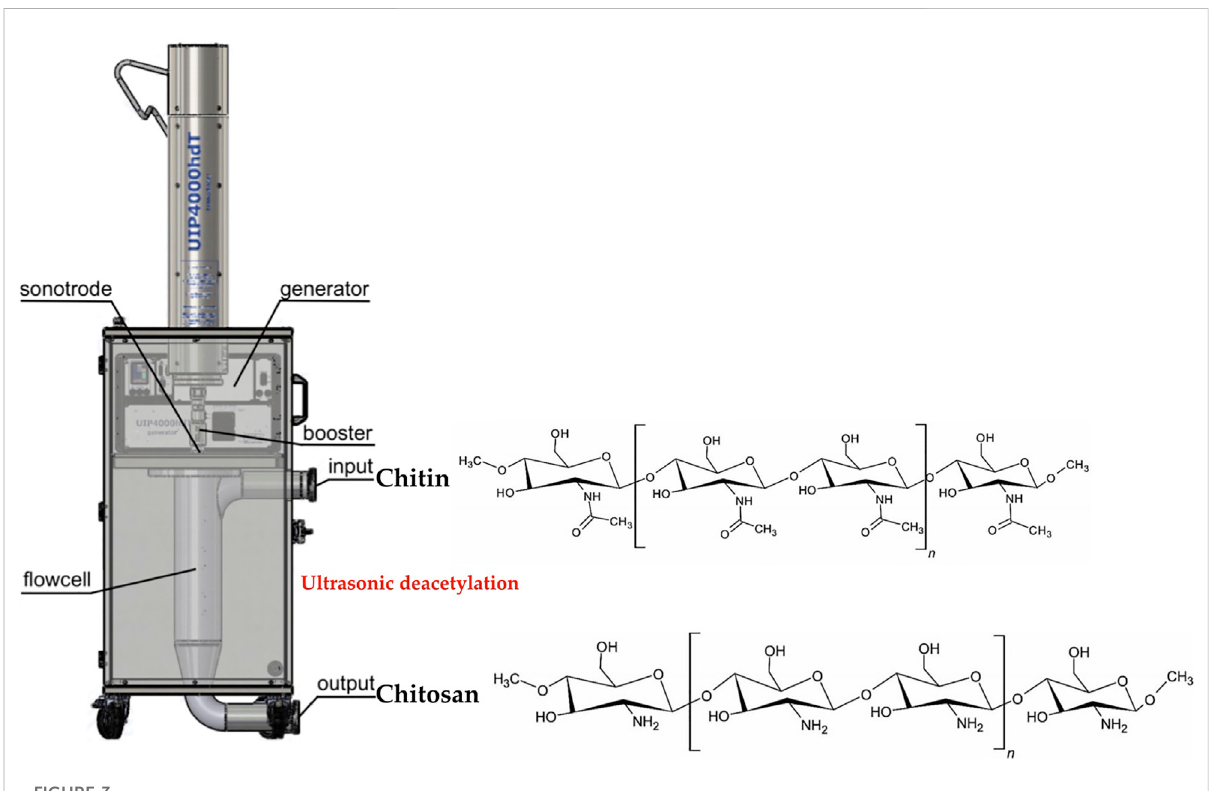
FIGURE 3 Chitin deacetylation